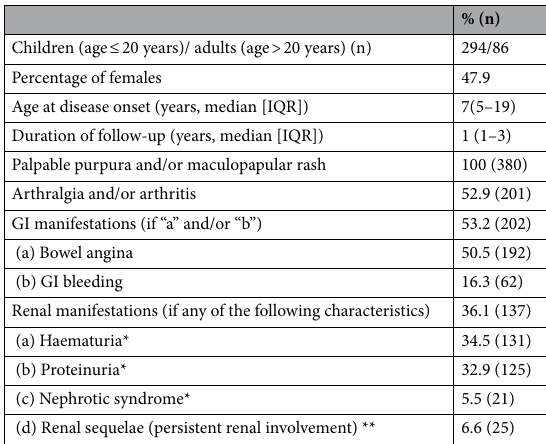
Table 1. Main clinical features of the 380 patients with IgAV included in the study. IgAV: IgA vasculitis; IQR: interquartile range; GI: gastrointestinal. *At any time over the clinical course of the disease. **At last